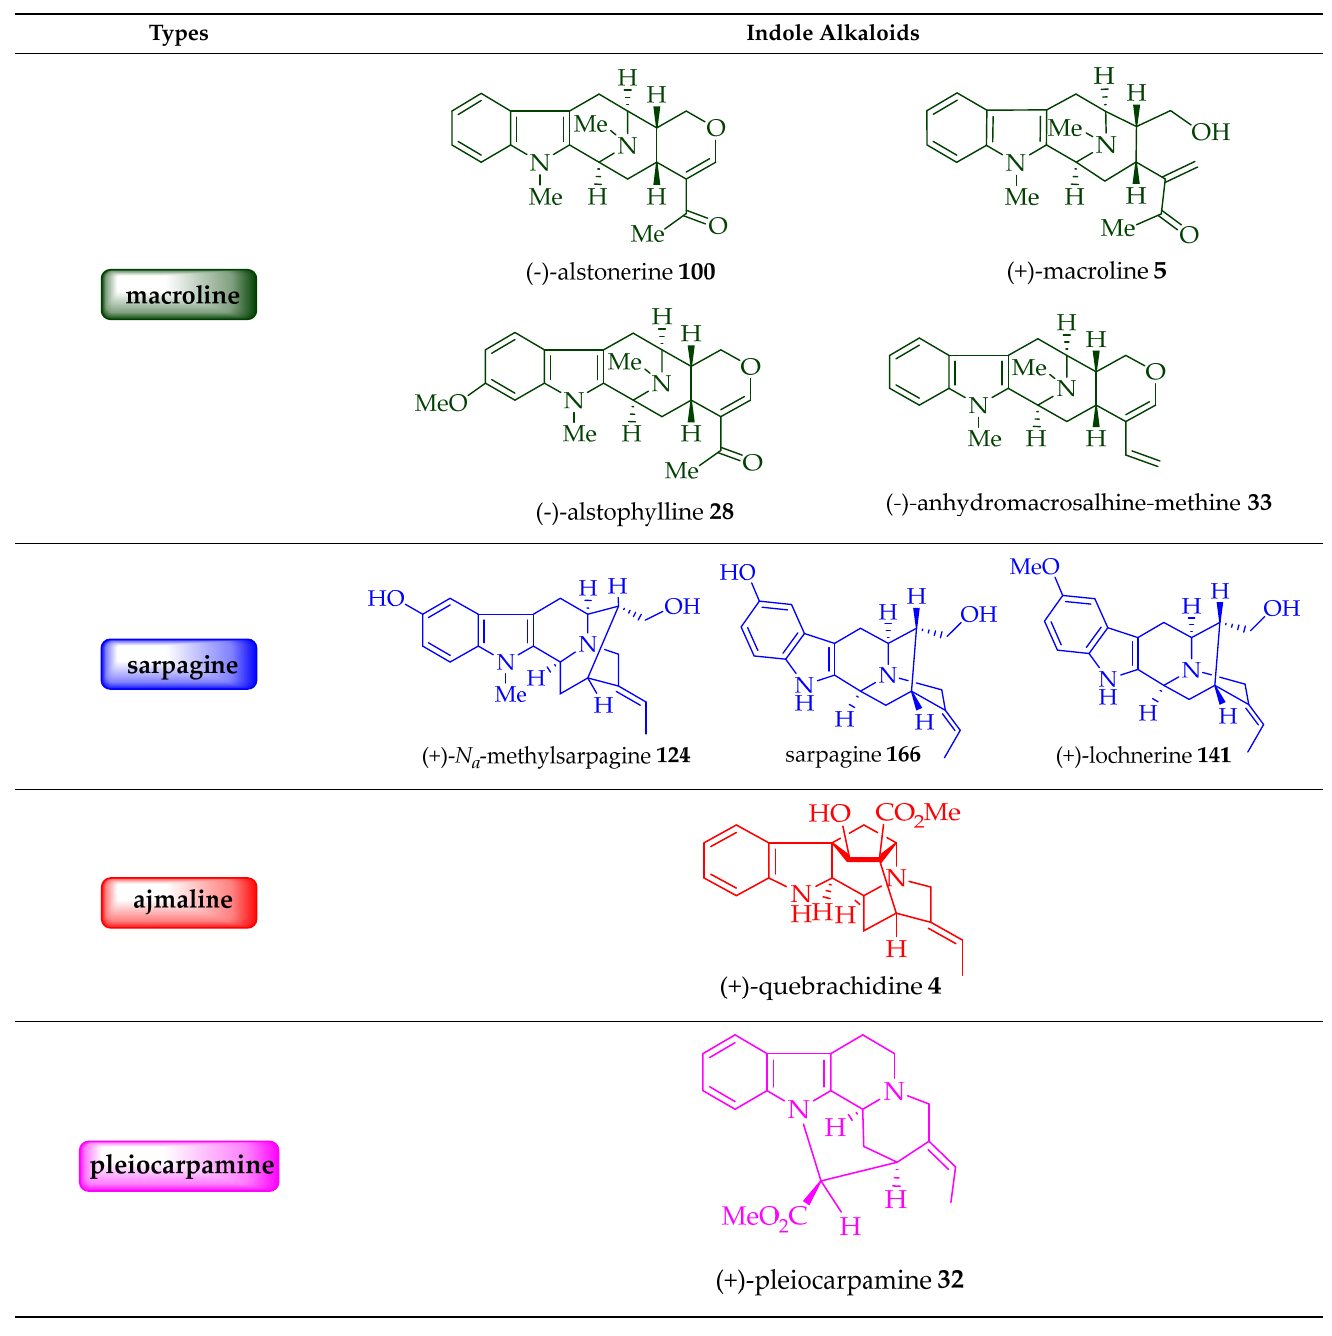
Table 2. Bisindoles from Alstonia species that are reviewed herein.